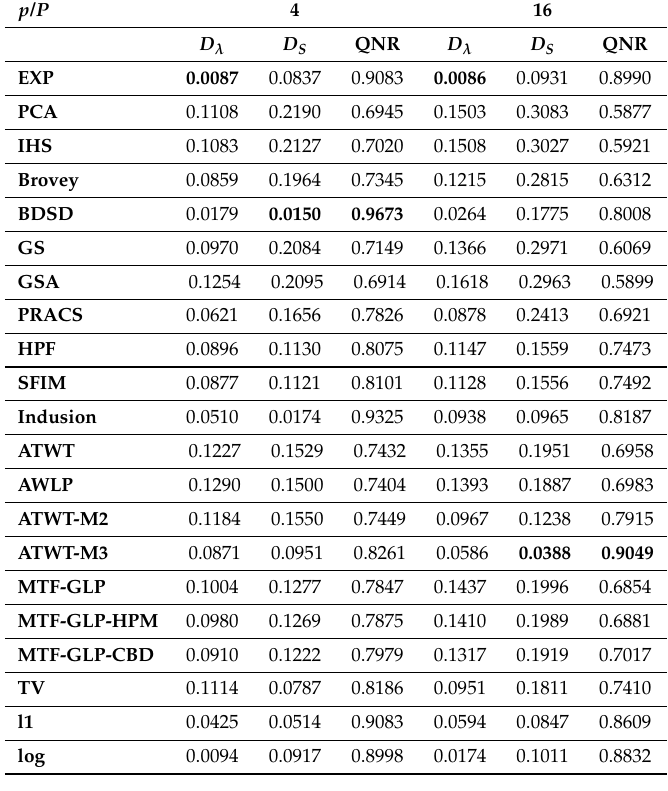
Table 12. QNR quantitative results on the FORMOSAT-2 Salon-de-Provence image. Bold values indicate the best score.